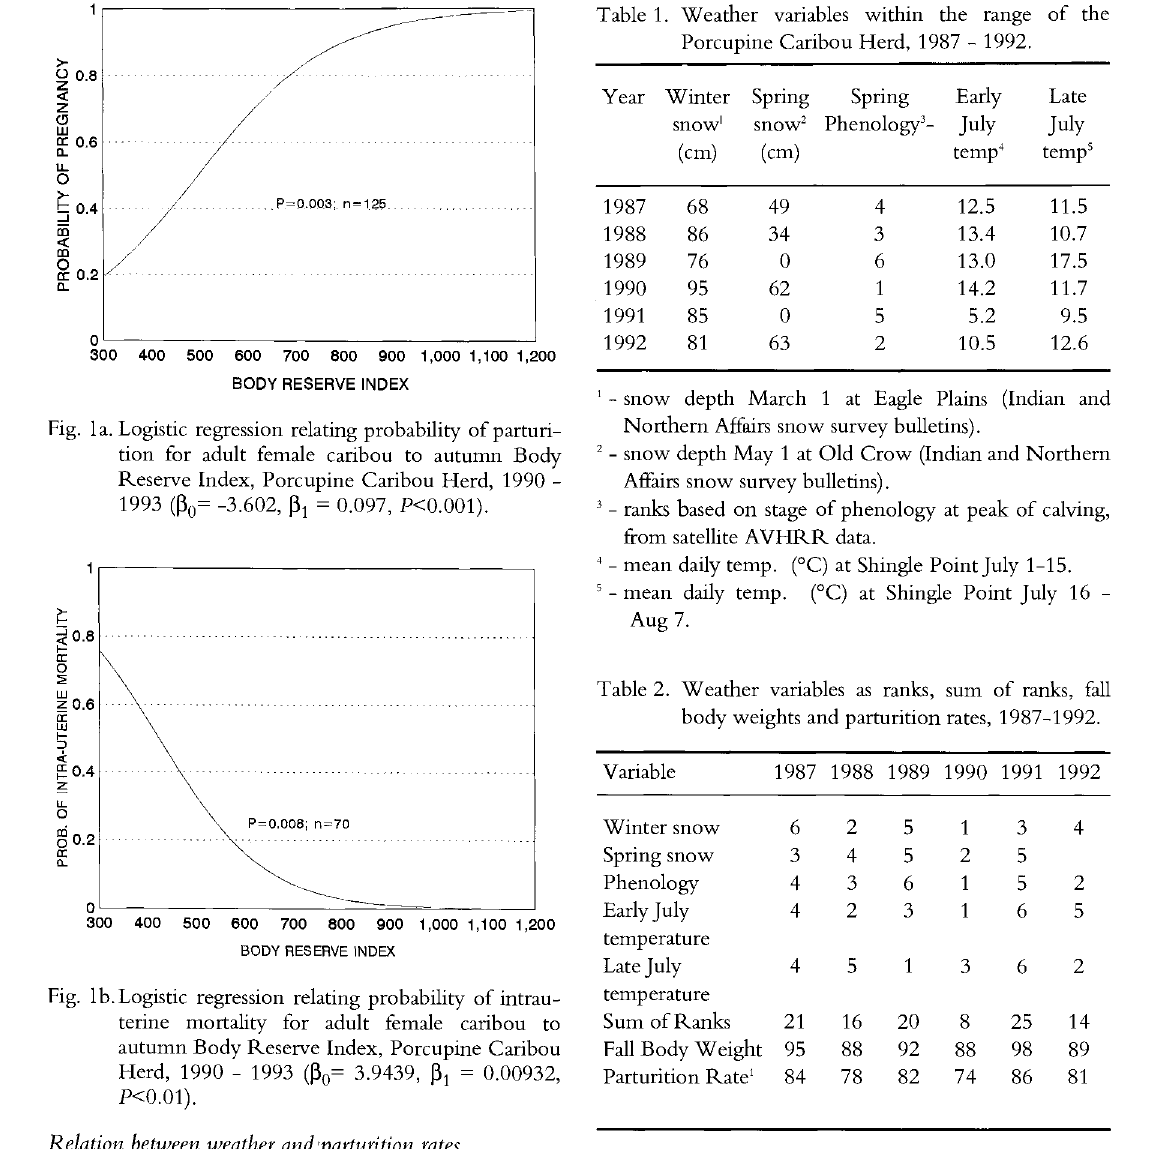
Fig. lb.Logistic regression relating probability of intrau terine mortality for adult female caribou to autumn Body Reserve Index, Porcupine Caribou Herd, 1990 - 1993 (P 0 = 3.9439, Pj = 0.00932, PO.01).